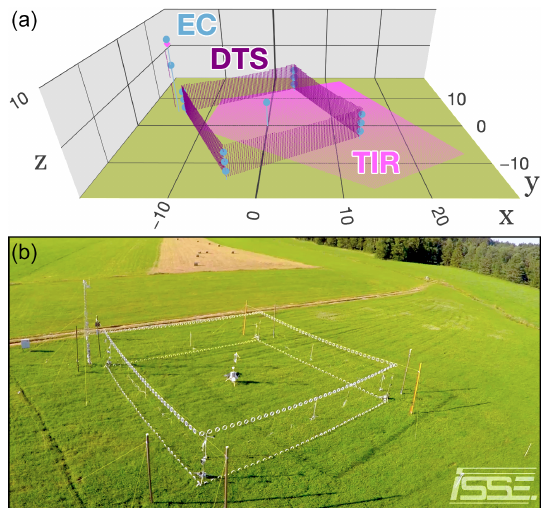
Figure 2. Overview of the setup in (a) schematic perspective and (b) a bird’s-eye view from the south. Still image has been mod- ified from an aerial video by Martin Schörner (24 July 2016, ISSE/University of